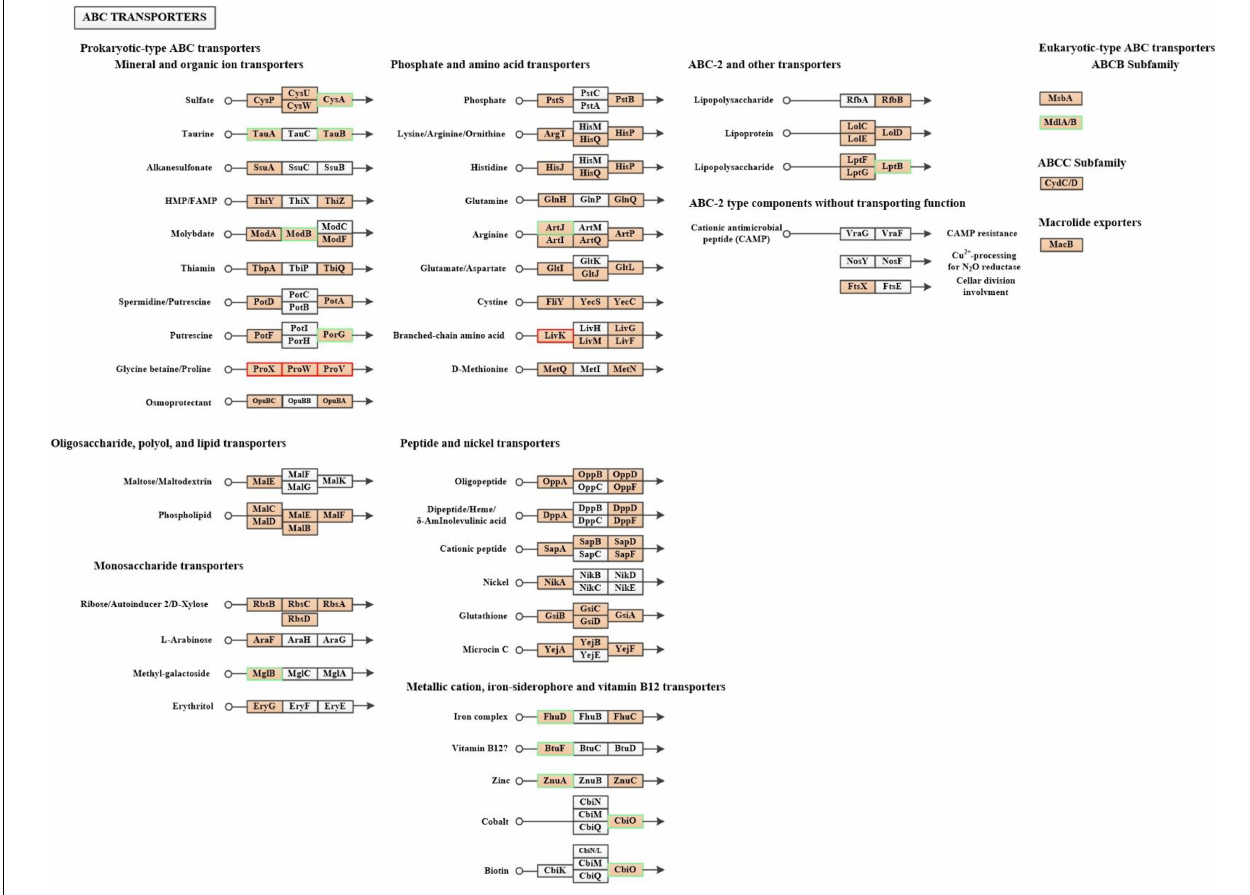
FIGURE 6 | The ABC transporters of the G40 is compared with the G120–20 (+betaine) in KEGG pathway map. Proteins in orange block belong to the 3,284 proteins and in white block belonged to the undetected sample. Up-regulated proteins are marked by red, whereas down-regulated proteins are marked by green in 461 differential proteins. (The abbreviations for full name of all proteins are given in Supplementary Table 3